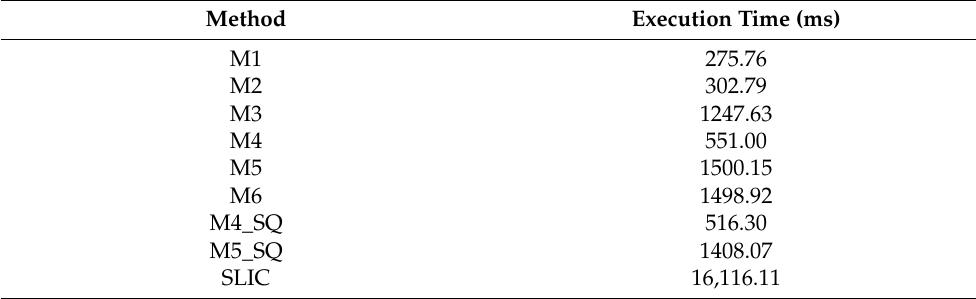
Table 3. Execution time of leaf detection algorithm.